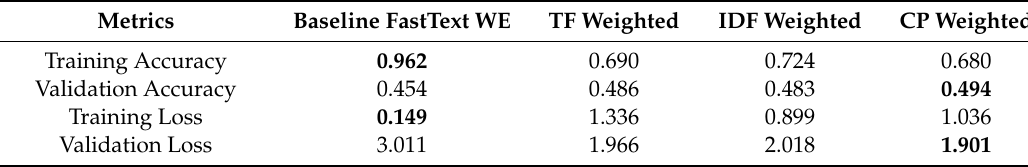
Table 2. Training and validation accuracy and loss results of the BLSTM model with all the proposed feature vector techniques (bold scores show the best result in a row).